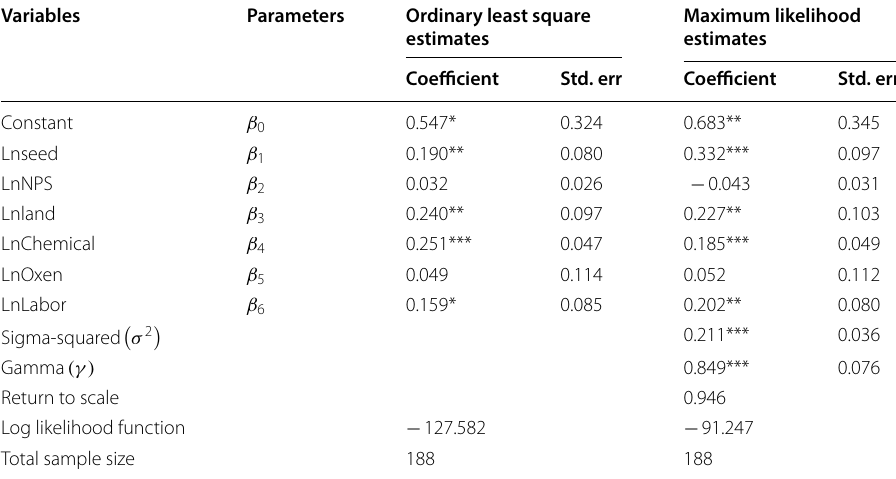
***, ** and * are statistically significant at 1%, 5% and 10%,